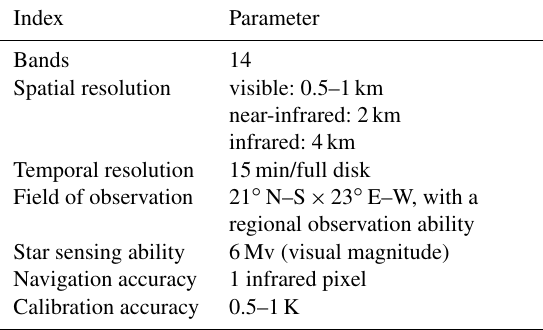
Table 1. Main parameters of